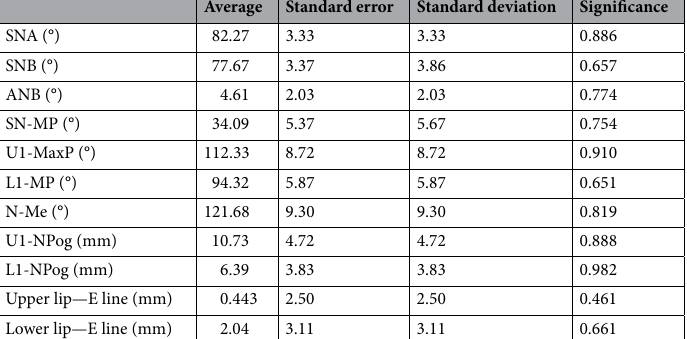
Table 1. Assessment of systematic bias between groups I, II, and III using one-way